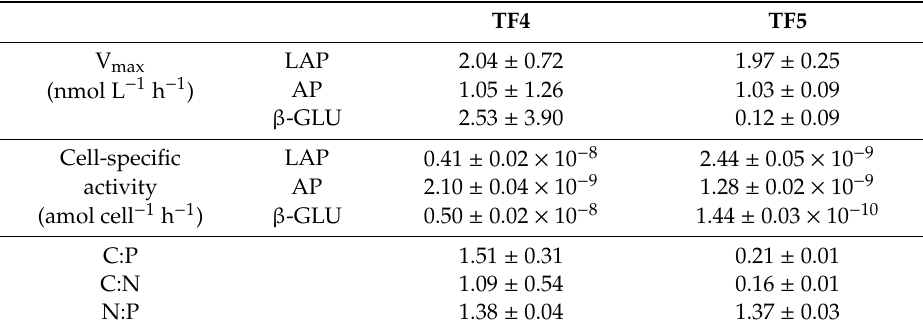
Table 3. Mean values ± standard deviation of the bulk maximum rates of enzymatic hydrolysis V max , cell-specific enzymatic activities and reciprocal molar ratios of the enzymatic activities measured in the two brine samples.